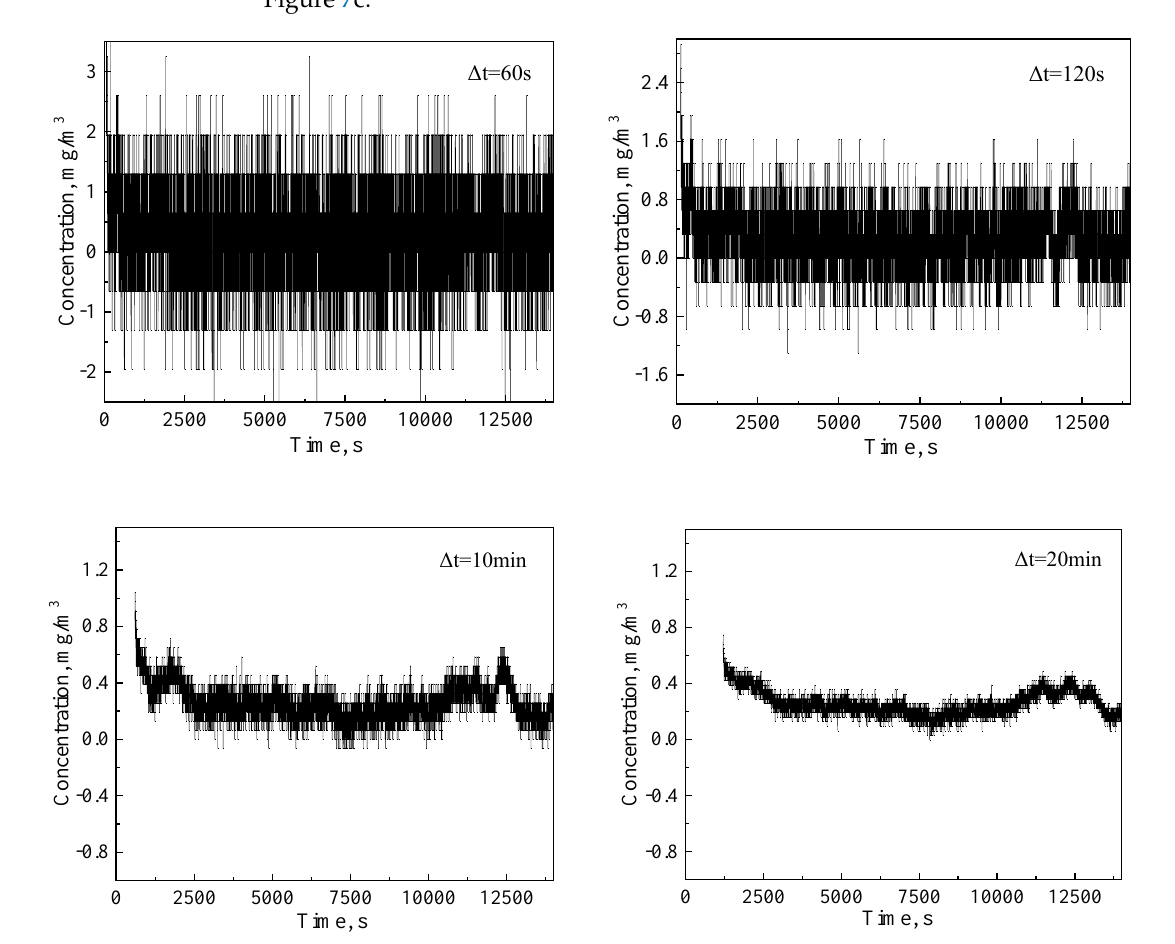
Figure 5. PM 2.5 concentration calculated with intervals of 60 s, 120 s, 10 min, and 20 min.